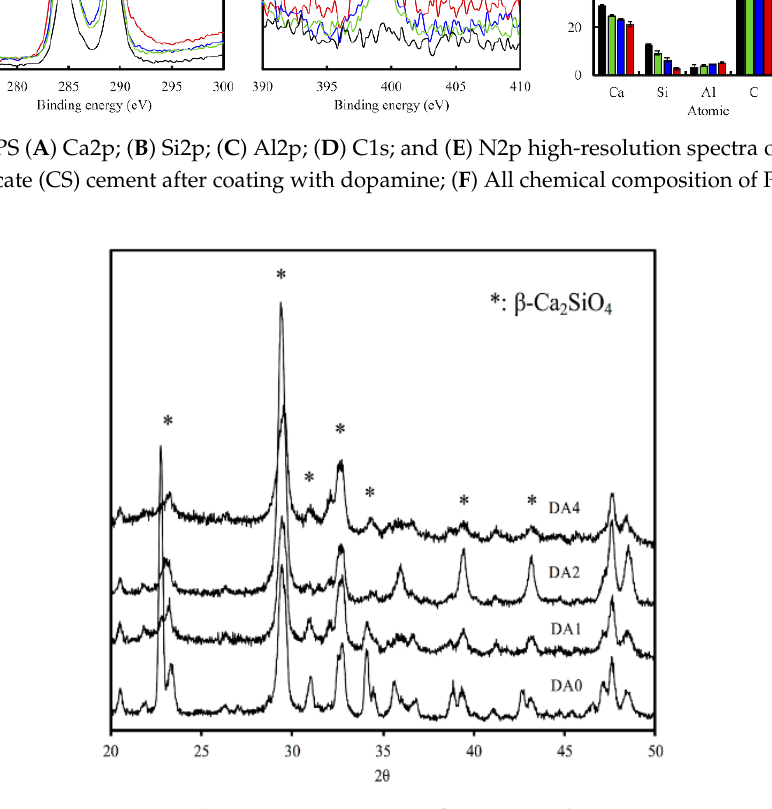
Figure 3. Injectability of various concentration of PDA-coated CS pastes after versus setting time.